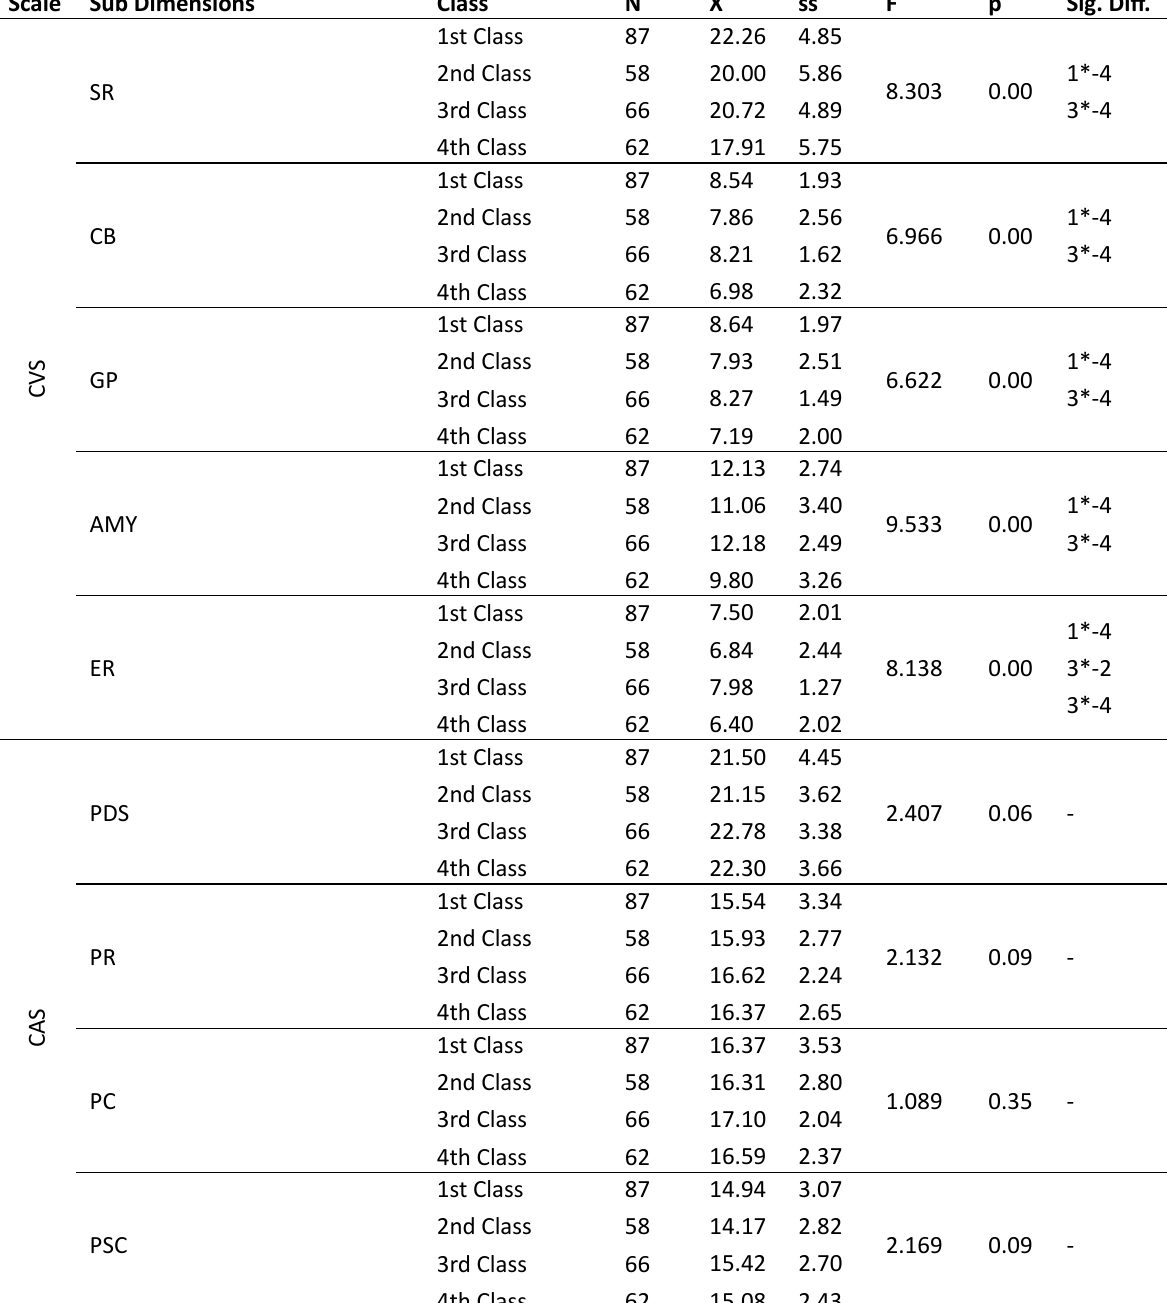
Table 6. Anova-Test results of participants’ CVS and CAS sub-dimensions in terms of the variables of Class